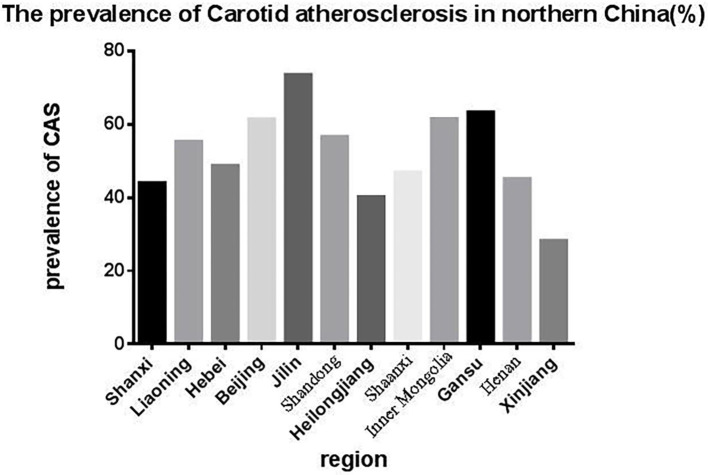
The prevalence of CAS in northern China, which was highest in Jilin and lowest in Xinjiang.